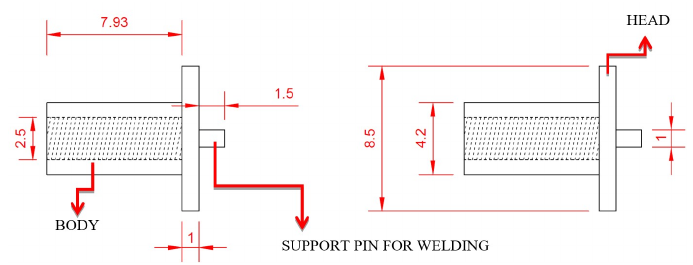
Figure 3. Rivet measurements in mm